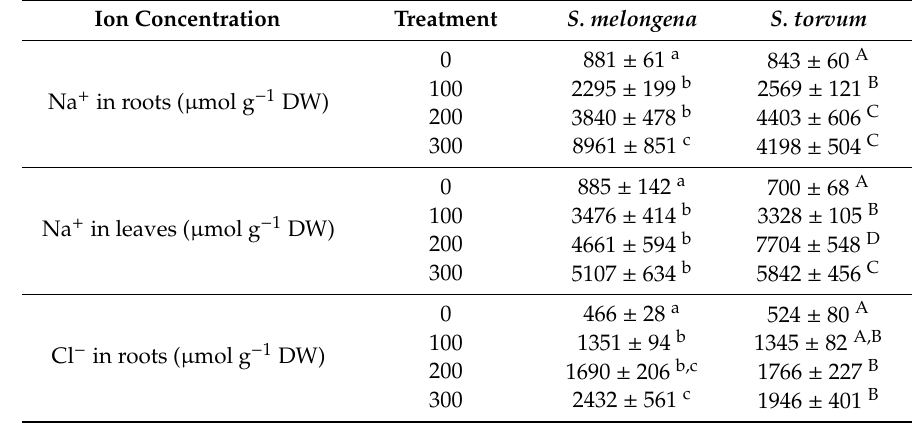
Table 5. Monovalent ion contents (mean ± SE, n = 5) in roots and leaves of Solanum melongena and S. torvum plants after 25 days of treatment with the indicated NaCl